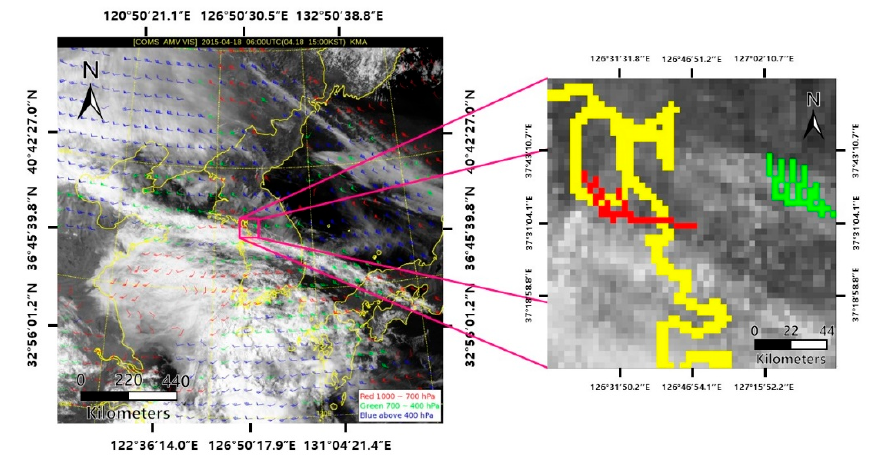
Figure 3. An exemplary satellite image of AMV with ROI.